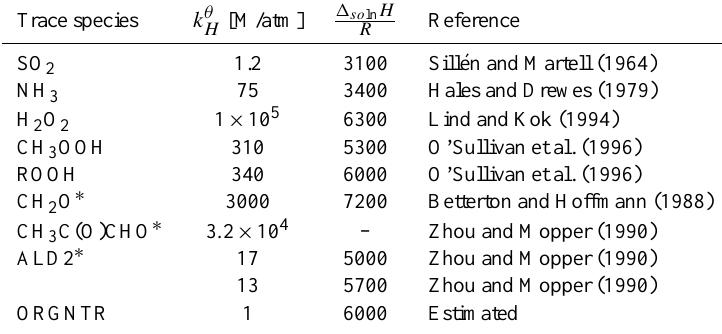
Table 5. Details concerning the chemical data used for the calculation of heterogeneous scavenging rates, where 1 so ln H is the enthalpy of solution, k θ is the Henry’s law coefficient at 298.15K and R the gas constant. For the species containing a -CHO functional group (denoted H by *) a hydration rate is also applied which further enhances the solubility in aqueous solution. For ALD2 an average is calculated from the uptake values for CH 3 CHO and C 2 H 5 CHO, whereas for ROOH the uptake value for C 2 H 5 OOH is adopted. For the species exhibiting